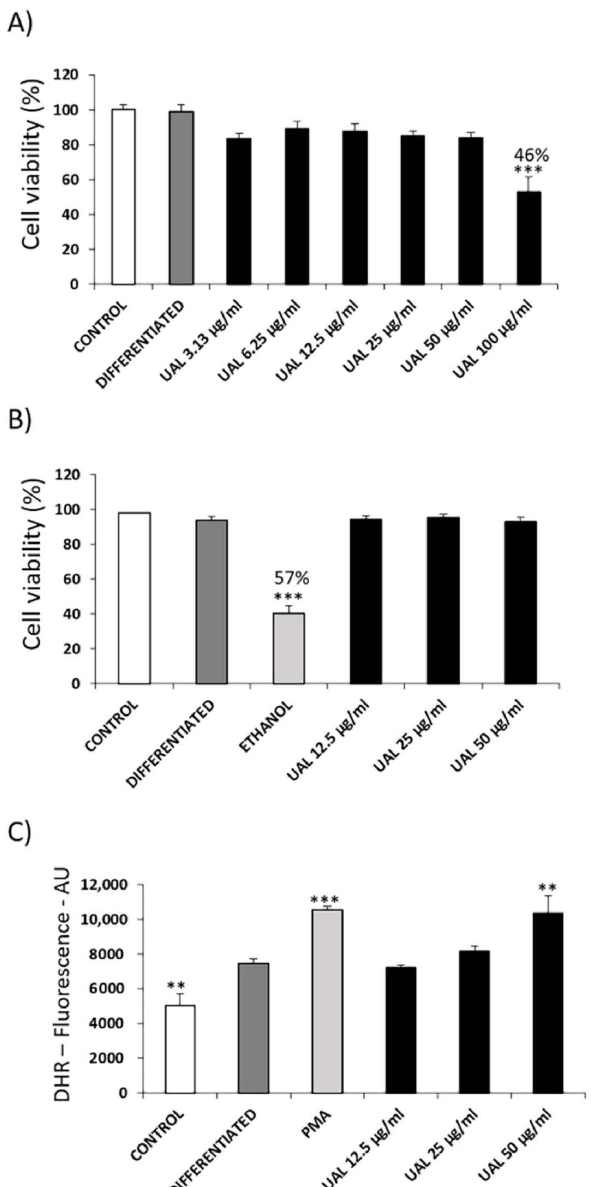
Figure 4. Effect of UAL on cell viability and oxidative burst in differentiated 3T3-L1 adipocytes. ( A ) 3T3-L1 cells were differentiated and treated with various doses (0–100 µ g/mL) of UAL. Cell viability was measured by the MTT assay after 7 days of treatment. Values are expressed as mean ±